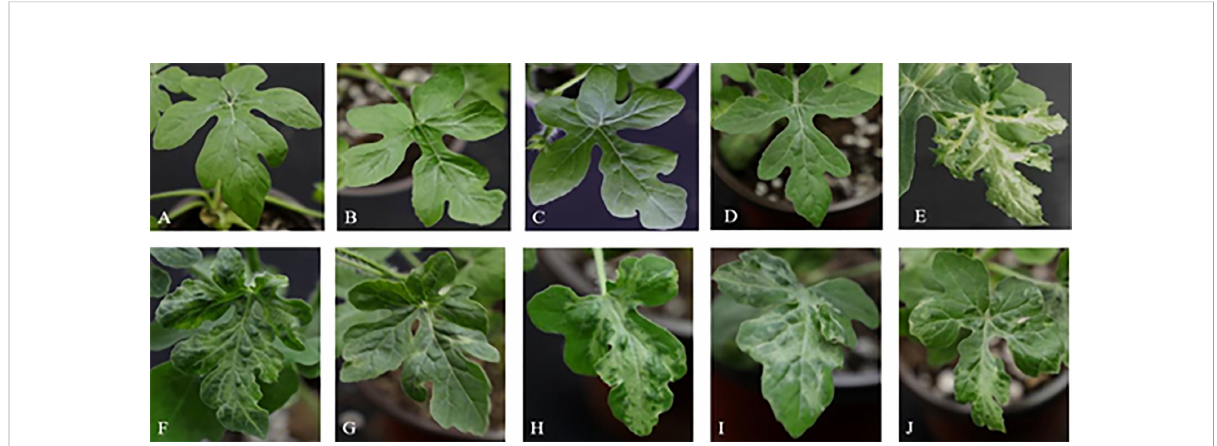
FIGURE 8 Leaf phenotypic analysis of candidate gene silencing. Phenotype of (A) blank control, (B) water control, (C) medium control, (D) blank vector control, (E) positive control, (F) silencing Cla97C02G036010 , (G) silencing Cla97C02G036030 , (H) silencing Cla97C02G036040 , (I) silencing Cla97C02G036050 , (J) silencing Cla97C02G036060